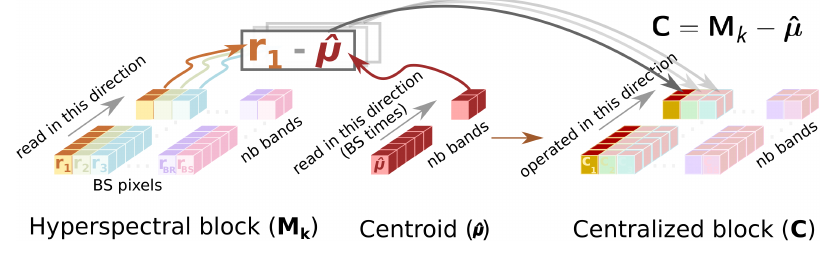
Figure 4. Overview of Cent